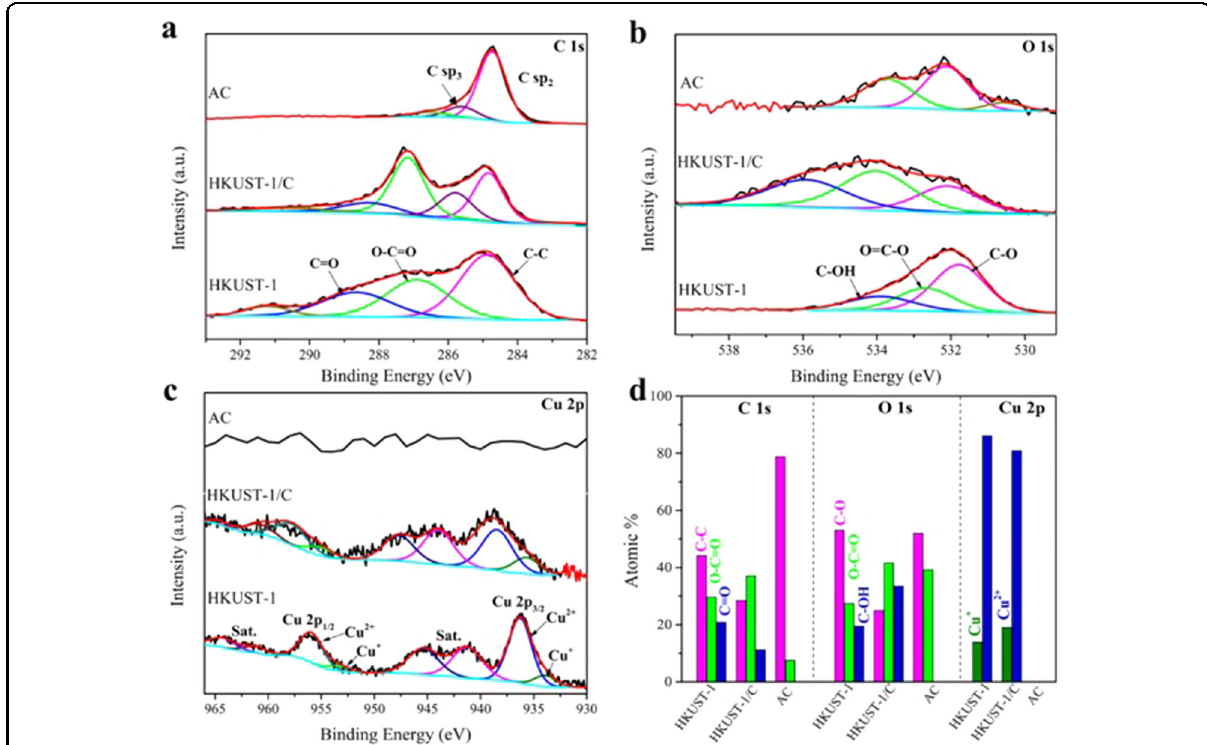
Fig. 3 Chemical analysis by X-ray photoelectron spectroscopy. XPS spectra indicating ( a ) C 1 s, ( b ) O 1 s, and ( c ) Cu 2p binding energies for HKUST-1, HKUST-1/C, and carbon. ( d ) Histogram showing a comparison of the atomic percentages obtained from the XPS